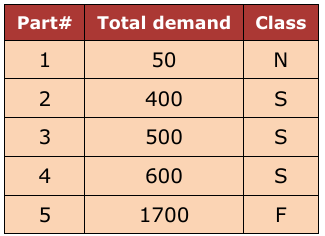
Table 2. Example of FSN